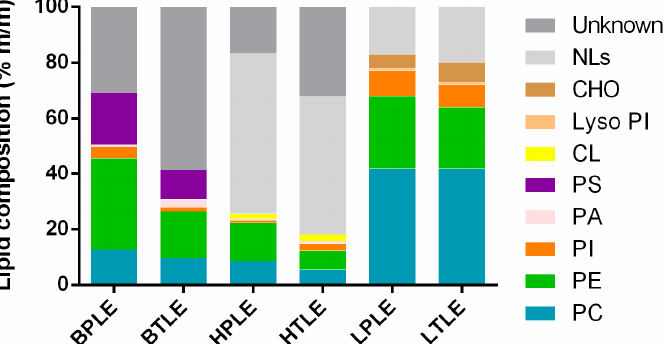
Figure 4. Lipid composition of the tissue-specific extracts. BPLE — brain polar lipid extract, BTLE — BTLE—brain total lipid extract, HPLE—heart polar lipid extract, HTLE—heart total lipid brain total lipid extract, HPLE — heart polar lipid extract, HTLE — heart total lipid extract, LPLE — liver polar lipid extract, LTLE — liver total lipid extract, PC — phosphatidylcholine, PE — phosphati- dylethanolamine, PI — phosphatidylinositol, PA — phosphatidic acid, PS — phosphatidylserine, CL —